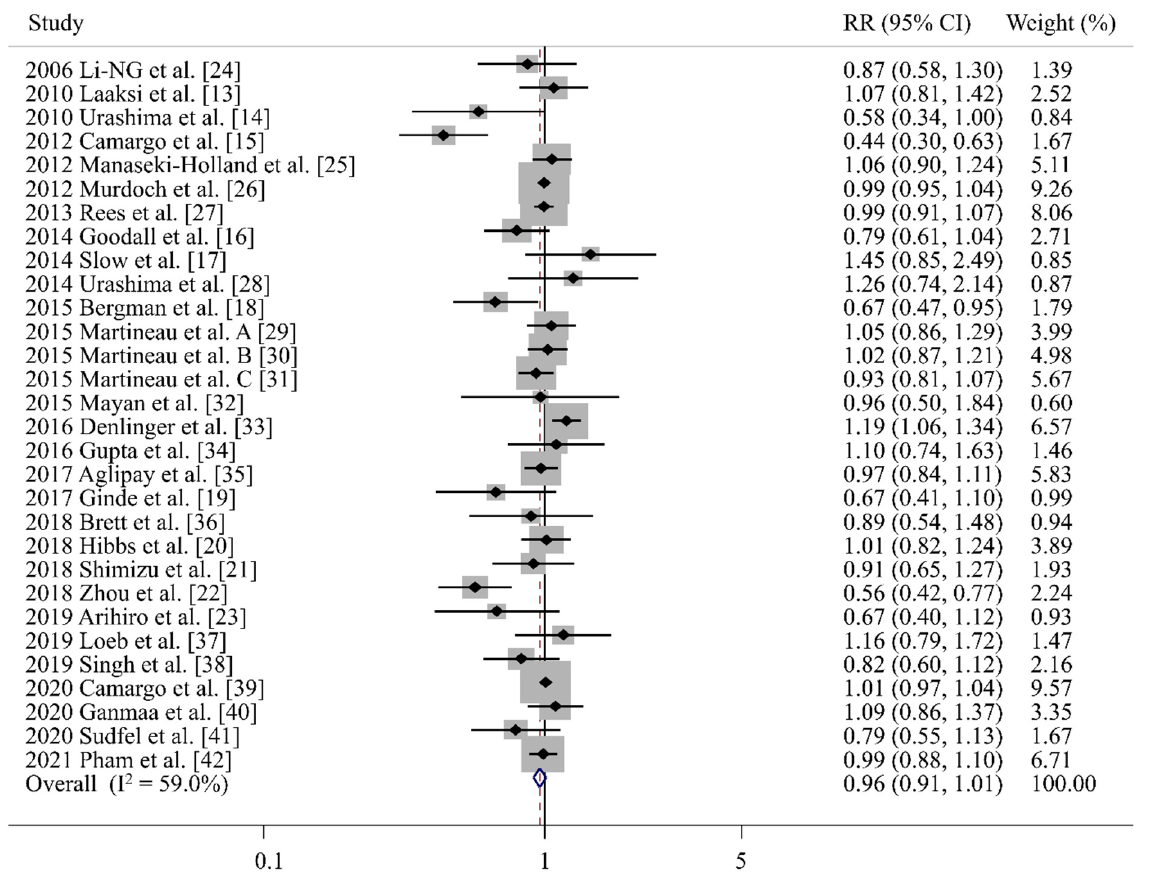
Figure 2. Efficacy of vitamin D supplements in prevention of acute respiratory infections in a meta-analysis of randomized controlled trials ( n = 30) [13–42]. RR, relative risk; CI, confidence interval; A, trial of vitamin D supplementation for prevention of Influenza (ViDiFlu); B, vitamin D3 supplementation in patients with chronic obstructive pulmonary disease (ViDiCO); C, vitamin D3 supplementation in adults with asthma (ViDiAs).